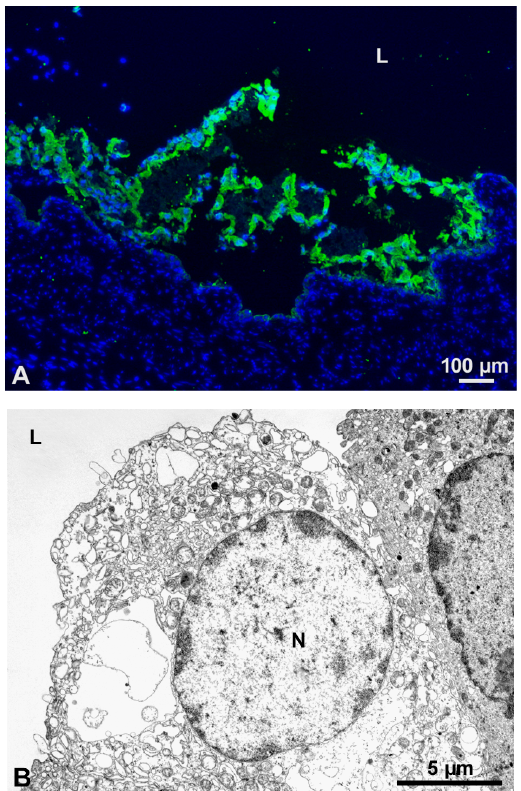
Figure 2. Chitosan induced umbrella cells desquamation (A) and necrosis (B). ( A ) Cytokeratin 20-positive umbrella cells (green fluorescence) detach from the urothelium after intravesical application of chitosan. ( B ) These cells have distinctive signs of necrosis under transmission electron microscope. N -nucleus, L -urinary bladder lumen.